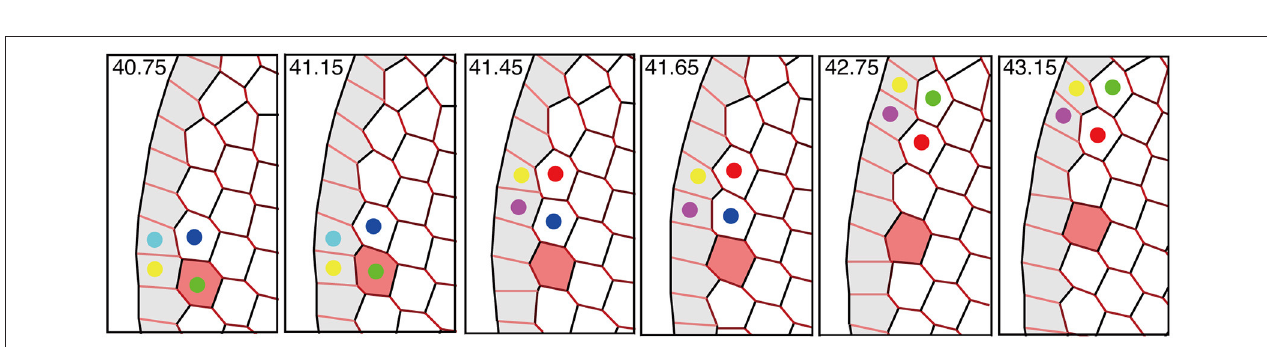
FIGURE 10 | Dependence of collective cell movement on chirality in the presence of tension fluctuation. (A) Dependencies of average quantities on the angle θ 0 in Equation (6). (B–D) Dependence of spatiotemporal correlation functions of fluctuations in the local angular velocity C vv ( ∆θ , ∆ t ) K p 7.5, (B) for θ 0 22.5 ◦ , (C) for θ 0 45 ◦ , and (D) for θ 0 67.5 ◦ . See Figure 6 for details. = = = =